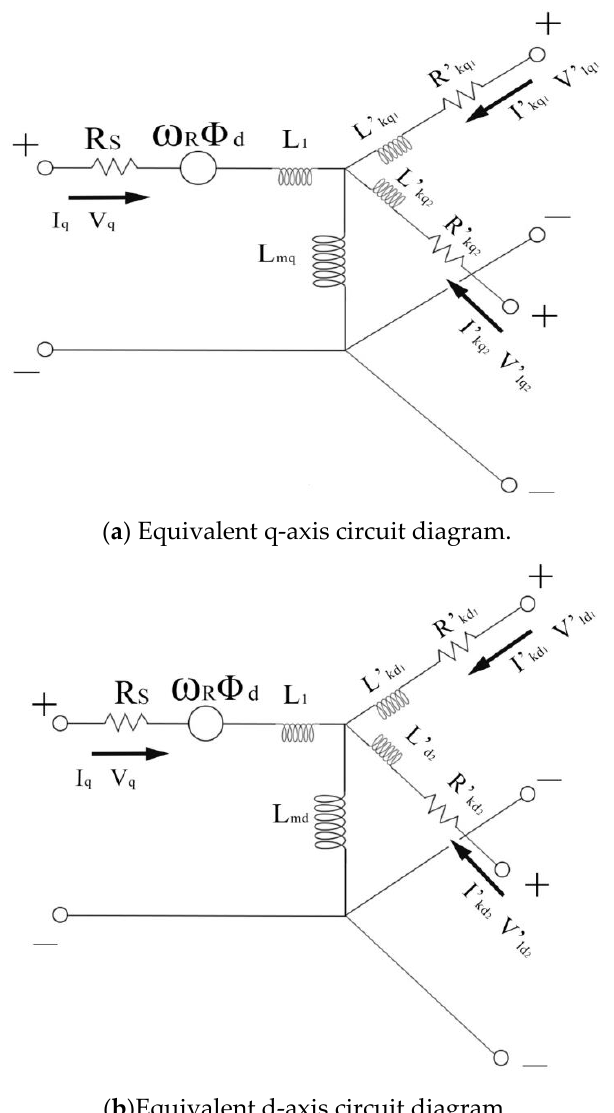
Figure 5. Synchronous generator model equivalent circuit diagram.